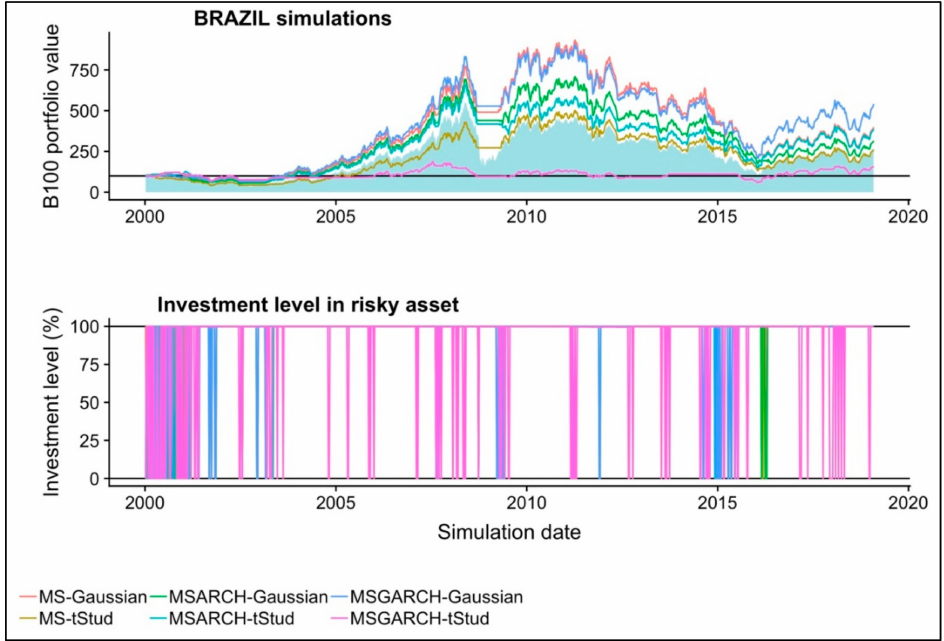
Figure 1. The historical performance of the six backtested portfolios in the Brazilian stock